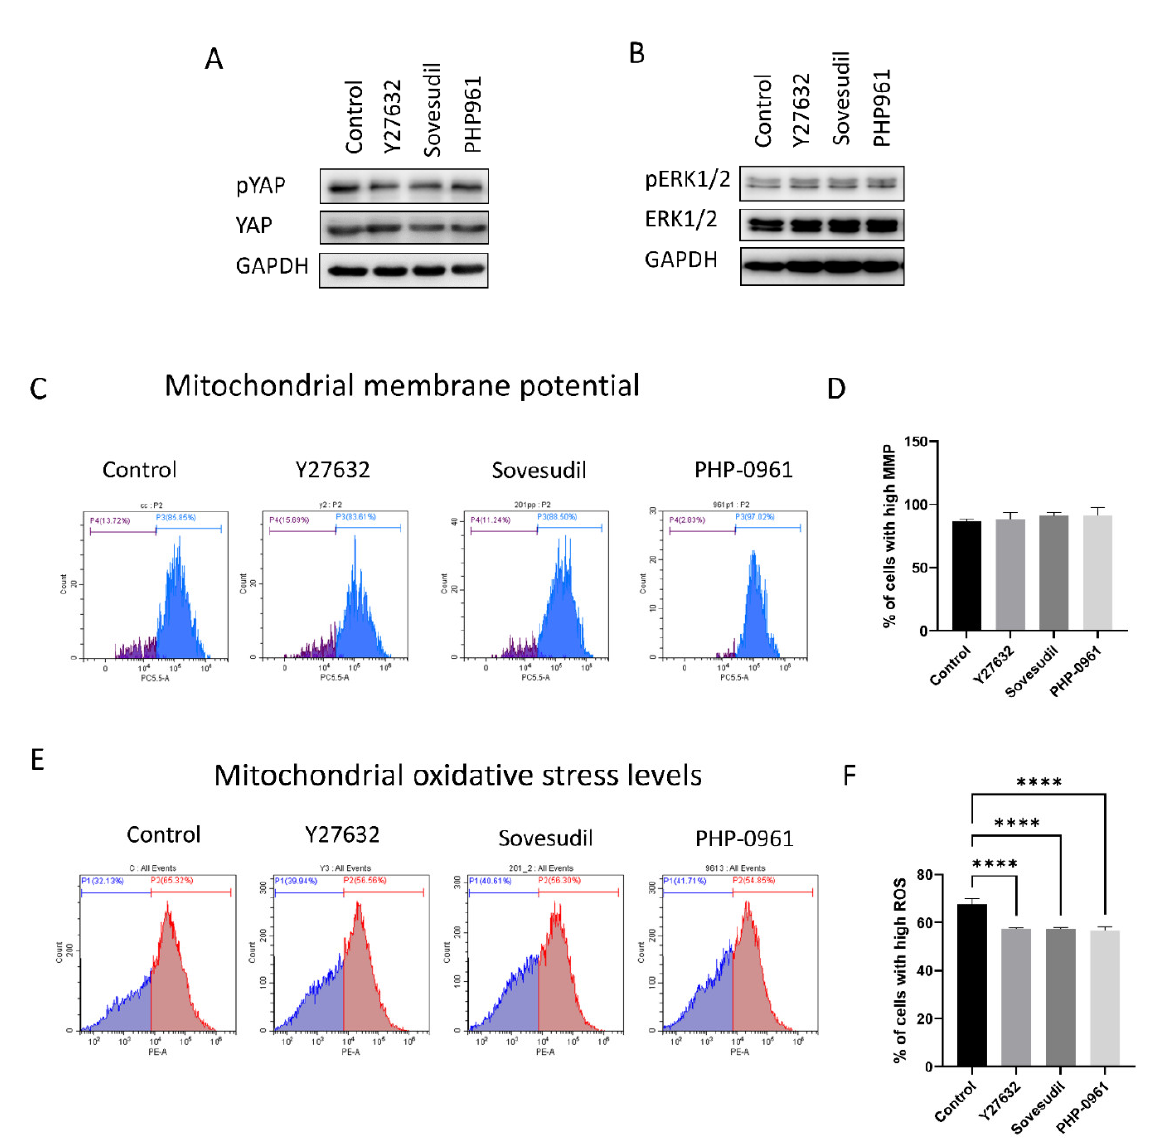
Figure 4. The signaling pathway and mitochondrial function were evaluated. ( A , B ) Phosphorylation of YAP and ERK1/2 was evaluated by Western blotting. ( C , D ) Mitochondrial membrane potentials were evaluated using the MitoPotential assay kit. ( E , F ) Mitochondrial oxidative stress levels were evaluated by MitoSOX red fluorescence intensity. **** p < 0.0001.